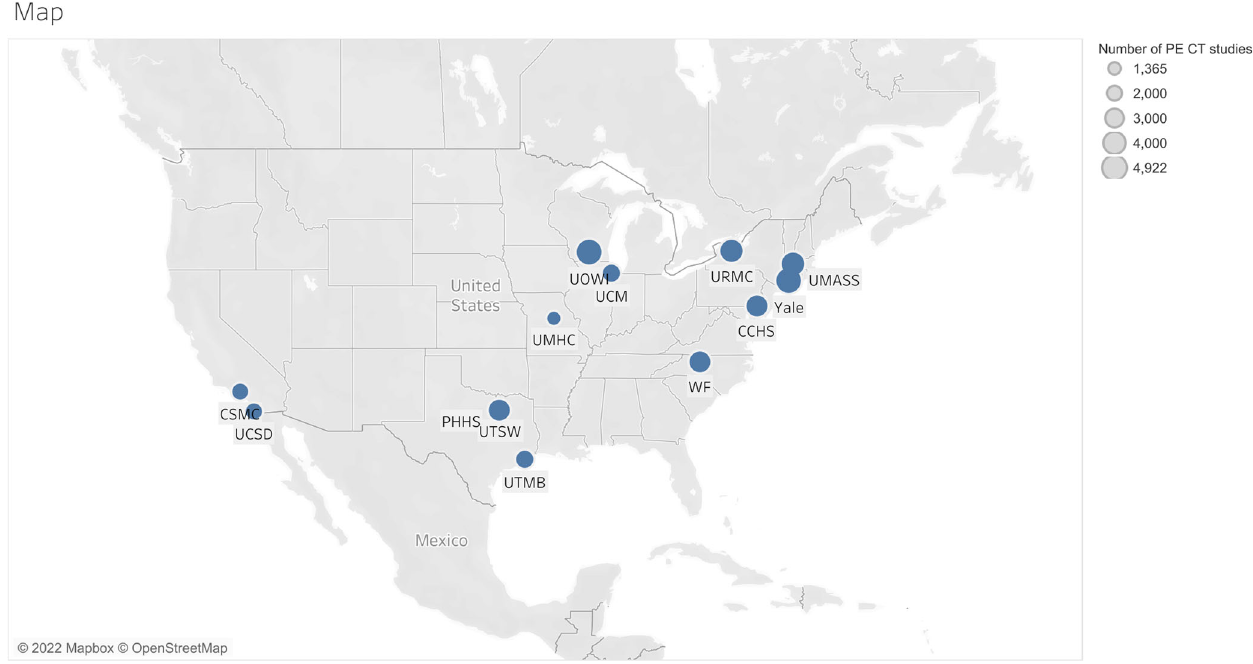
Fig. 5 Geographic distribution of the participating institutions. CCHS Christiana Care Health System, CSMC Cedars-Sinai Medical Center, PHHS Parkland Health and Hospital System, UCM University of Chicago, UCSD University of California, San Diego, UMASS University of Massachusetts, UMHC University of Missouri-Columbia, UOWI University of Wisconsin-Madison, URMC University of Rochester Medical Center, UTMB University of Texas-Medical Branch, UTSW University of Texas-Southwestern, WF Wake Forest School of Medicine. The size of the circle is proportional to the number of cases contributed to this study by that institution. The detailed information by the site is available online (https://www.aidoc.com/resources/research/). Base map © OpenStreetMap